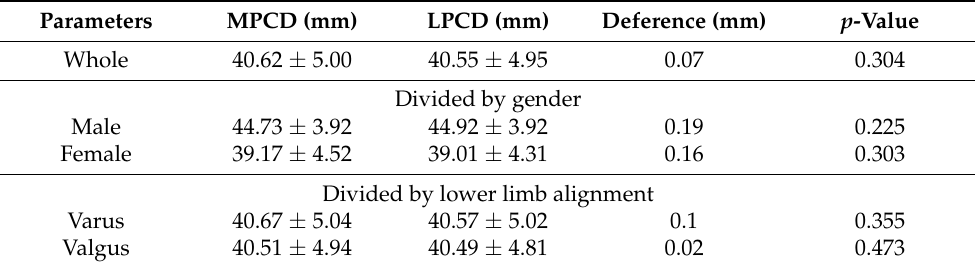
Table 3. Comparison of the medial and lateral posterior condylar diameters according to gender and lower limb alignment.